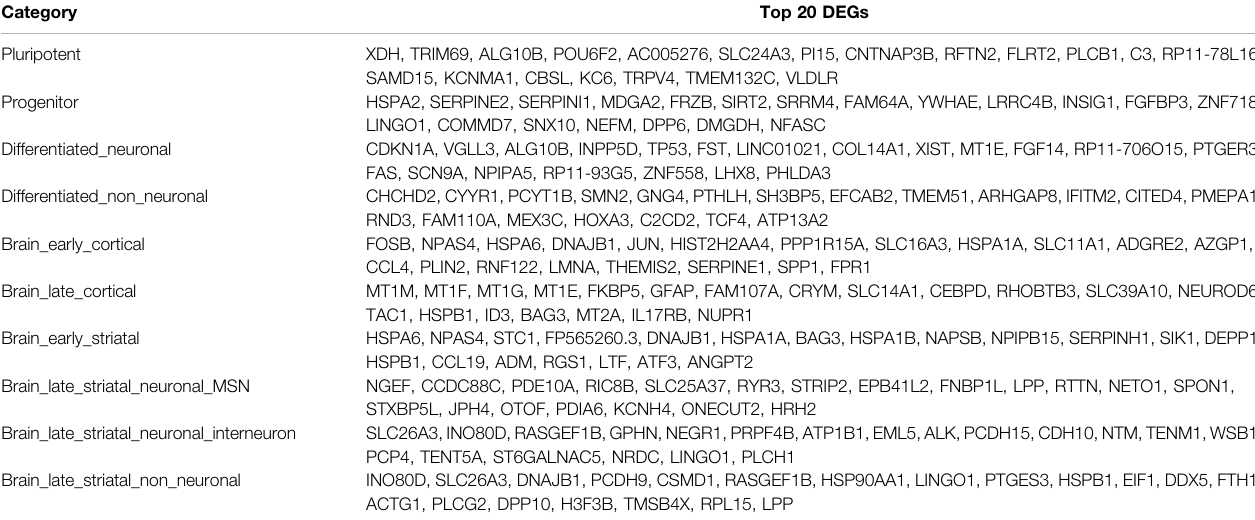
TABLE 2 | Human top differentially expressed genes (DEGs) in each category. The table summarizes the top DEGs in brain subcategories in human, fi rst ranked by the frequency of DEGs, then by the average FDR value of DEGs across all datasets in that subcategory. Category Top 20 DEGs